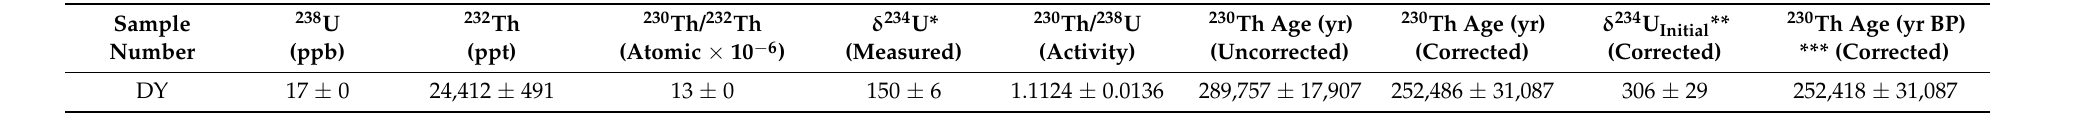
Table 2. Th-U dating results of calcite fillings in karst